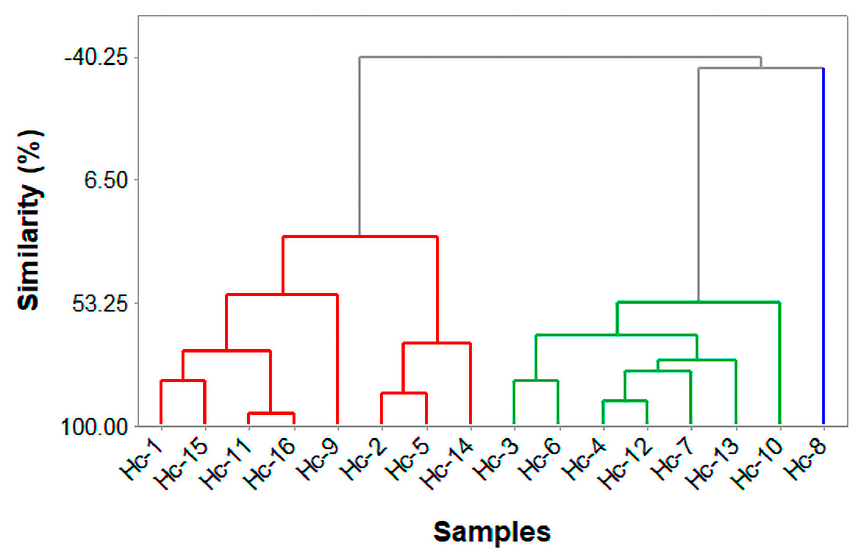
Figure 2. Hierarchical cluster analysis of Hyptis crenata essential oils samples.